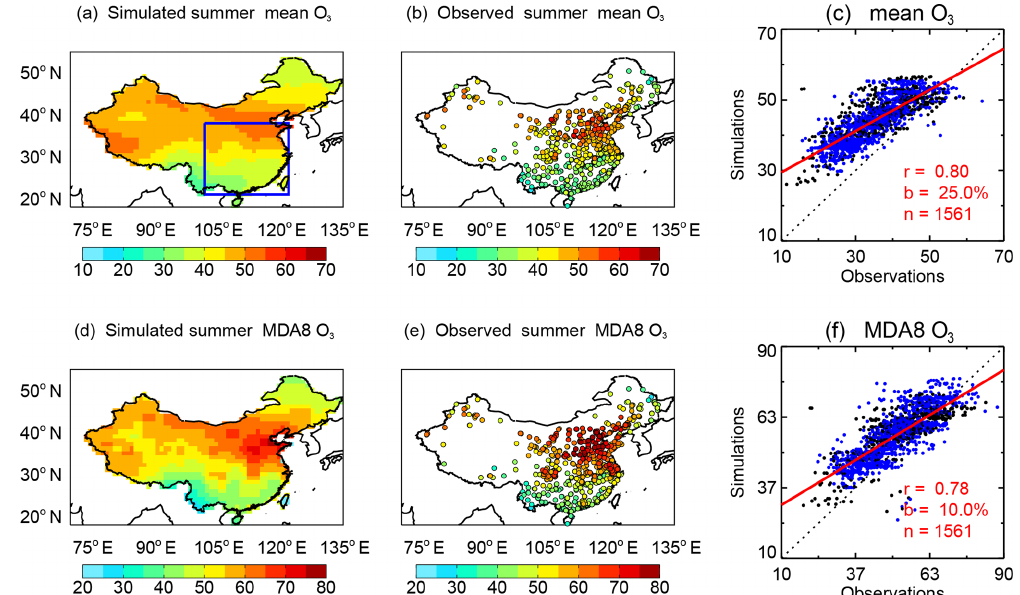
Figure 1. Evaluation of surface O 3 with site-level observations. Simulations are ensemble (a) mean and (d) daily maximum 8h aver- age (MDA8) O 3 for the period of 2005–2015 from 12 ACCMIP models. Observations (b, e) are the average during 2015–2018 from 1580 sites operated by Ministry of Ecology and Environment, China. The correlation coefficients ( r ), relative biases ( b ), and number of sites ( n , excluding sites lacking data) are shown in the scatter plots (c, f) . The blue points in the scatter plots represent sites located within the box regions in eastern China as shown in (a) . The dashed line represents the 1 : 1 ratio. The red line is the linear regression between simulations and observations.